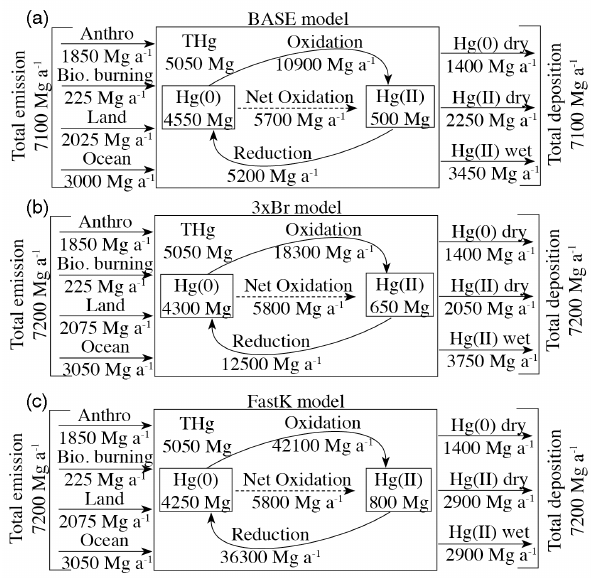
Figure 9. Annual global tropospheric budget of mercury in the (a) BASE, (b) 3 × Br, and (c) FastK simulations for 2013. The bur- dens are in units of Mg (10 6 g) and the fluxes are in units of Mga − 1 (Mg per